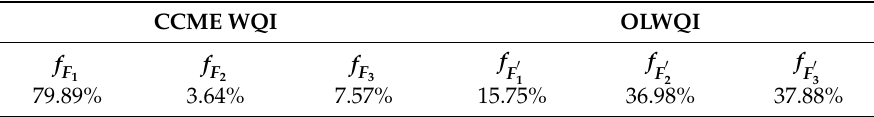
Table 7. Statistical Results of the Factor Effects on the Final